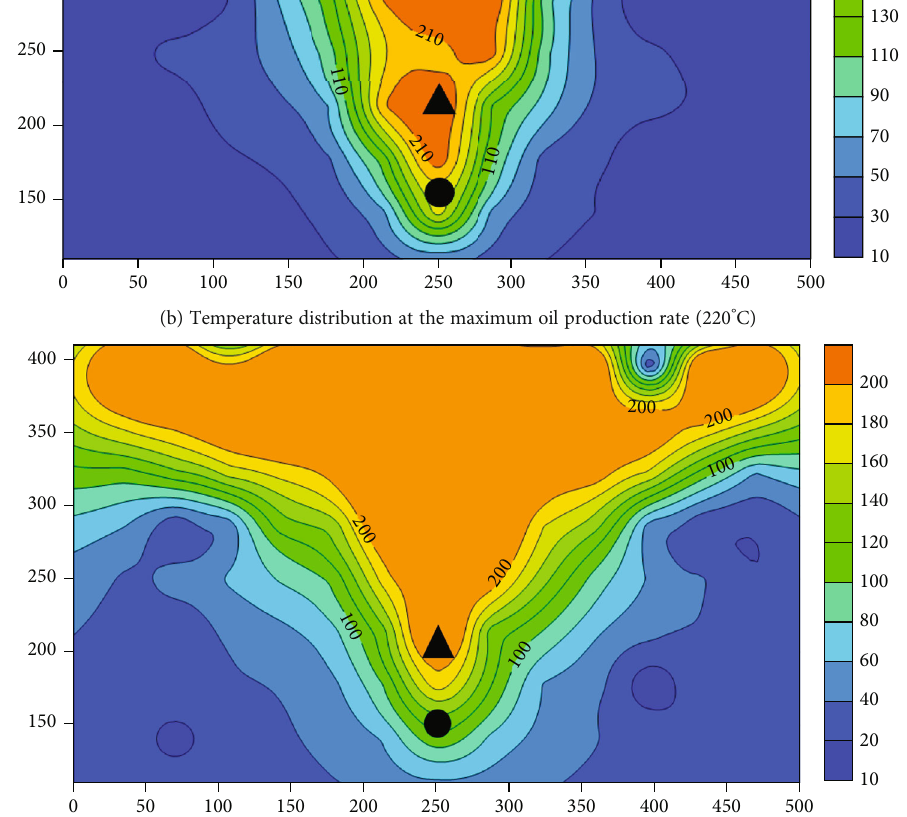
Figure 4: Temperature distribution in di ff erent periods (220 °